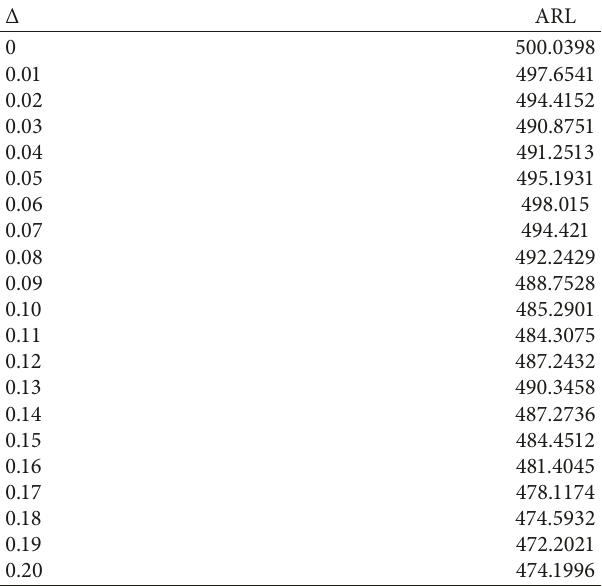
Table 12: Impact of estimation error for r � 2 and h � 78 .